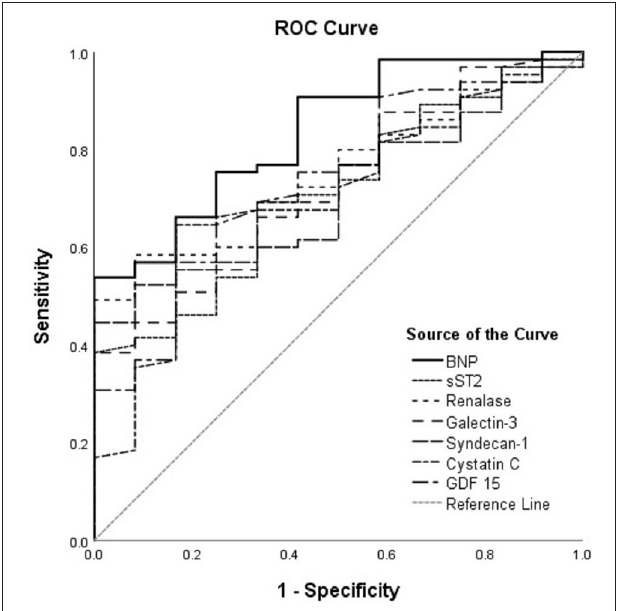
FIGURE 2 | ROC curves of renalase and evaluated biomarkers for the prediction of ischemia in the HFrEF phenotype. The curves should be interpreted with regard to Table 5 . AUCs: BNP (0.980), galectin-3 (0.747), sST2 (0.788), renalase (0.814), syndecan-1 (0.801), cystatin C (0.749), GDF-15 (0.731). ROC, receiver operating characteristic; AUC, area under the curve; BNP, brain natriuretic peptide; sST2, soluble source of tumorigenicity 2; GDF-15, growth differentiation factor